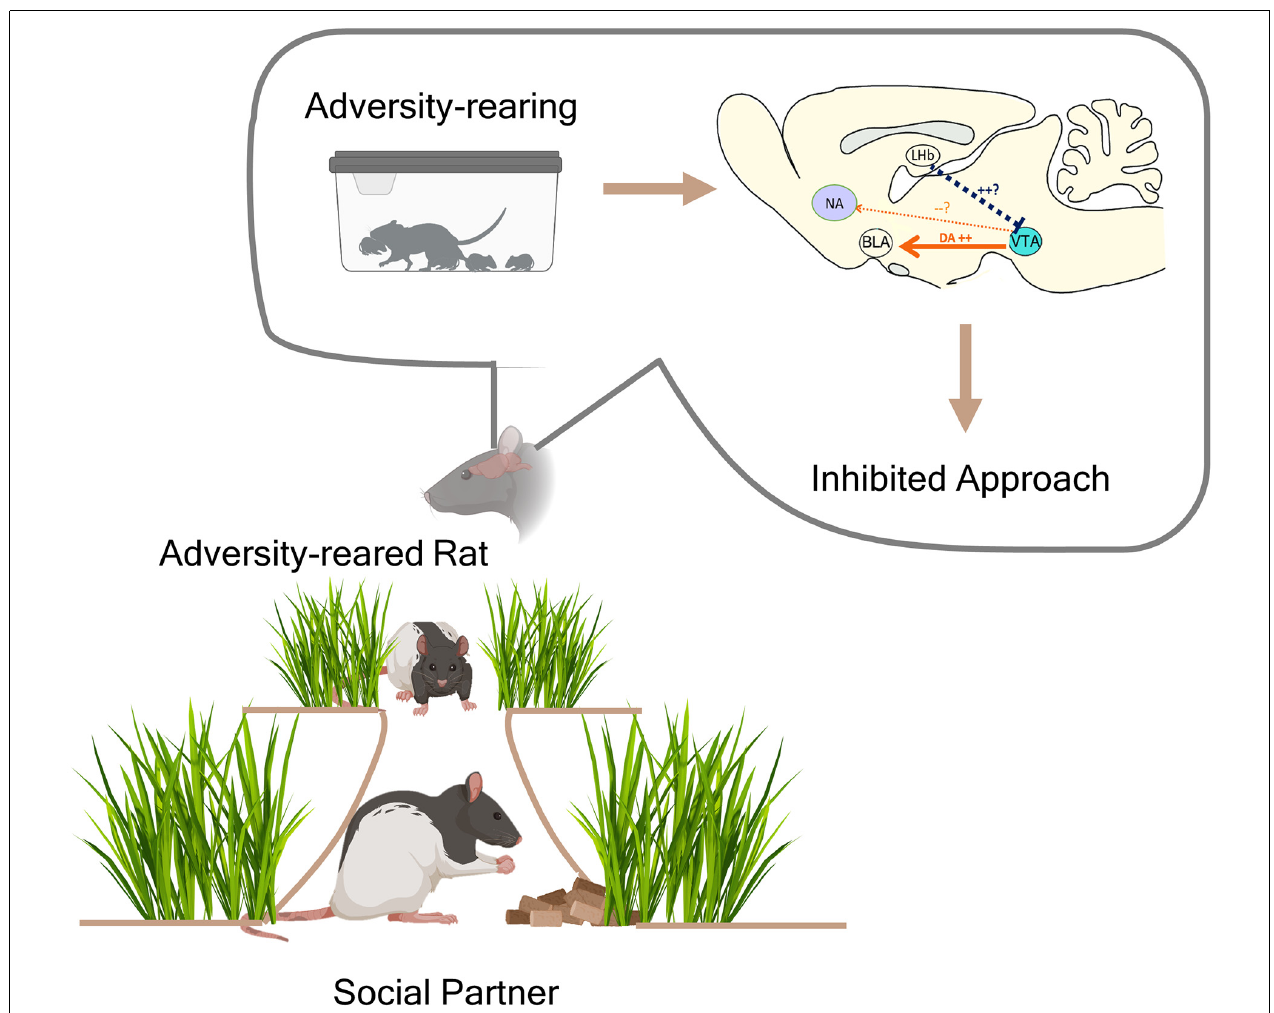
FIGURE 1 | Remodeled negative valence circuits inhibit social behavior after adversity. Following early life adversity with a caregiver, increased dopaminergic innervation from the ventral tegmental area (VTA) to the basolateral amygdala (BLA) results in decreased social approach toward a novel peer. Measurements during the adversity itself show that whereas caregiver presence typically suppresses dopamine (DA) release in the BLA during threat exposure, repeated adversity with the caregiver is accompanied by enhanced amygdala reactivity and DA release in the caregiver’s presence. This suggests that negative valence circuits are engaged in processing the caregiver and this produces lasting hyperactivity of these circuits in responding to social partners. Research now turns to the lateral habenula (LHb) as the site of dysfunction in social behavior, as this region inhibits DA release from the VTA to the classical reward locus of the nucleus accumbens. Based on recent work, we propose a model whereby early adversity produces LHb hyperactivity (blue dashed line) and inhibited DA release to the accumbens (NA); combined with enhanced DA release in the VTA, these circuit changes decrease the rewarding salience of social